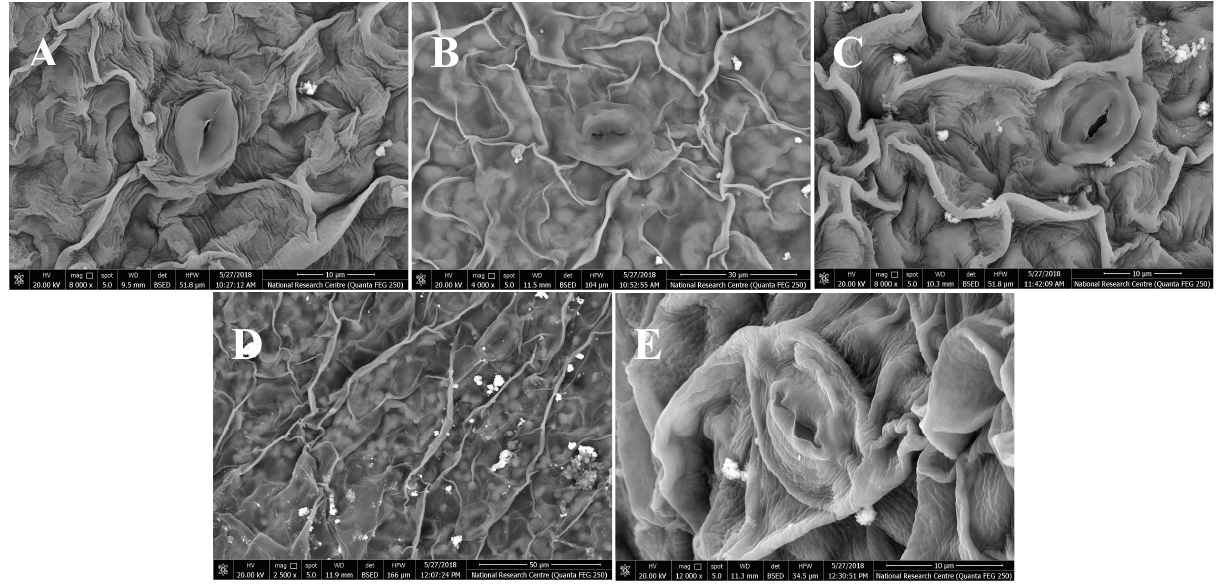
Figure 4. SEM micrographs of stomata level and ornamentation in Cichorium : A : C. intybus var. inty- bus ; B : C. intybus var. foliosum ; C : C. endivia var. endivia ; D : C. endivia var. crispum ; E : C. endivia subsp. pumilum .